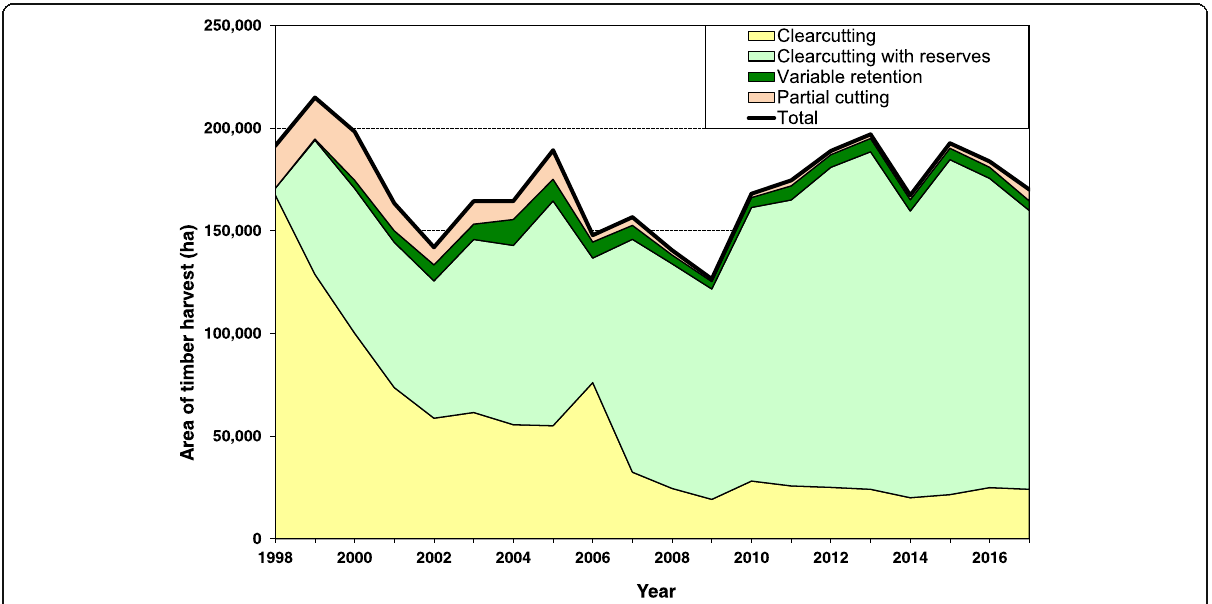
Fig. 2 Area harvested by silvicultural system over 20 years (1998 – 2017) on BC public lands. ‘ Partial cutting ’ includes seed tree, patch cut, shelterwood and selection systems, and intermediate cuts (e.g. thinning). Data from the Province of BC, Silviculture Statistics